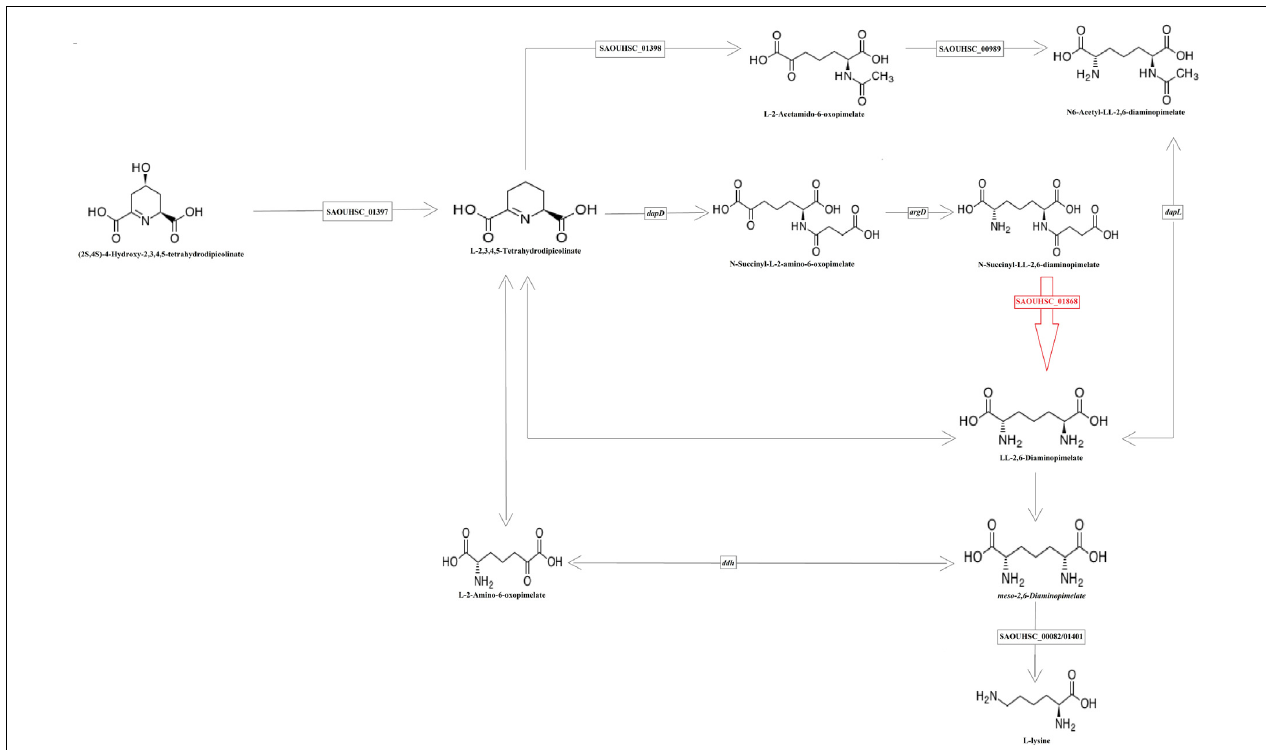
FIGURE 6 | Schematic overview of the partial reaction of lysine formation The enzyme encoded by the SAOUHSC_01868 (in red) regulates the production of lysine.